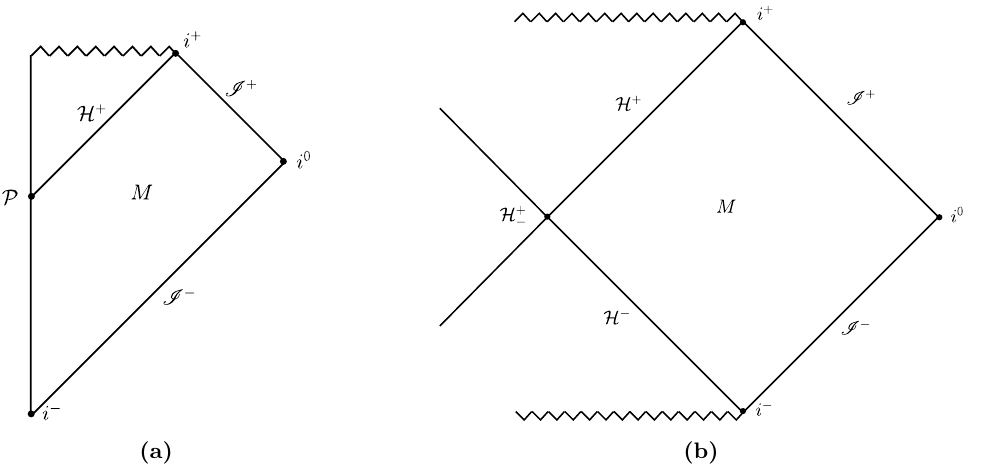
Figure 1. An illustration of two situations we will consider for the spacetime M . (a) M is taken to be the domain of outer communications of a black hole formed in a gravitational collapse, with boundary elements I (cid:0) , I + and H + . (b) M is taken to be the domain of outer communications of an eternal black hole, with boundary elements I (cid:0) , I + , H (cid:0) and H +